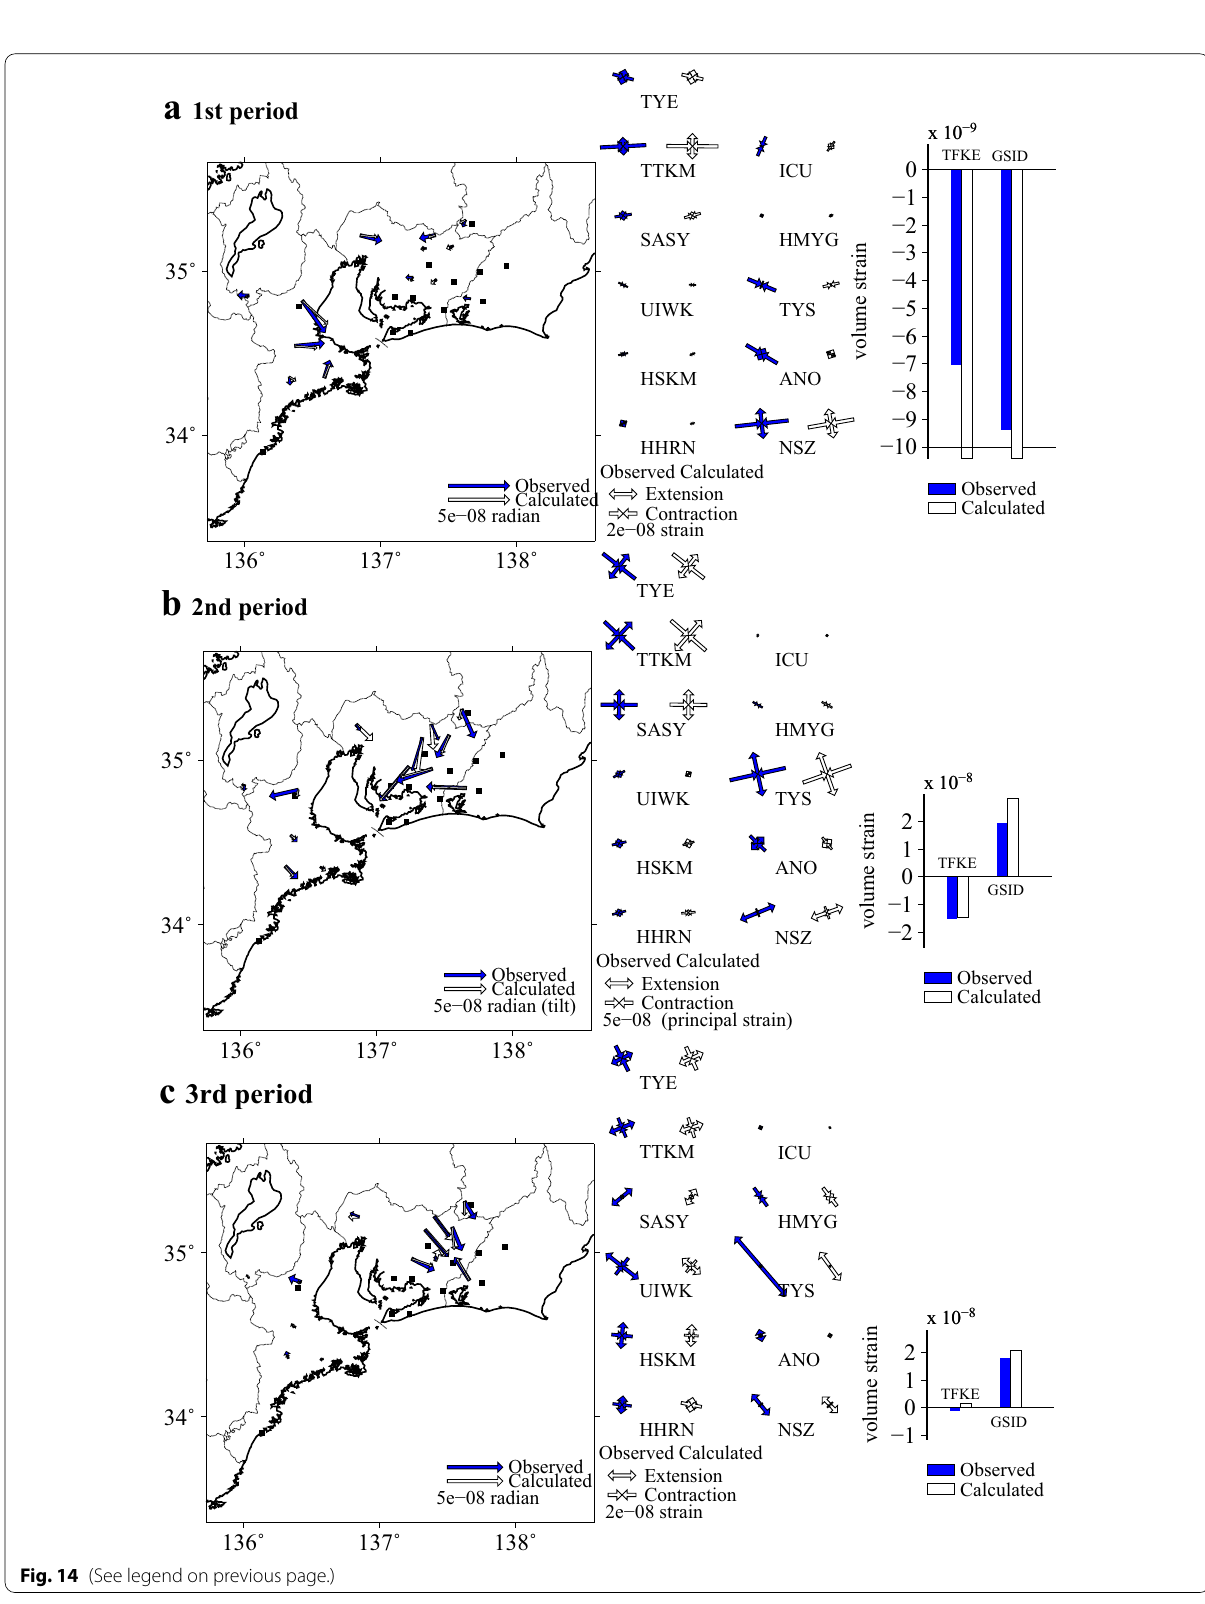
Fig. 14 (See legend on previous